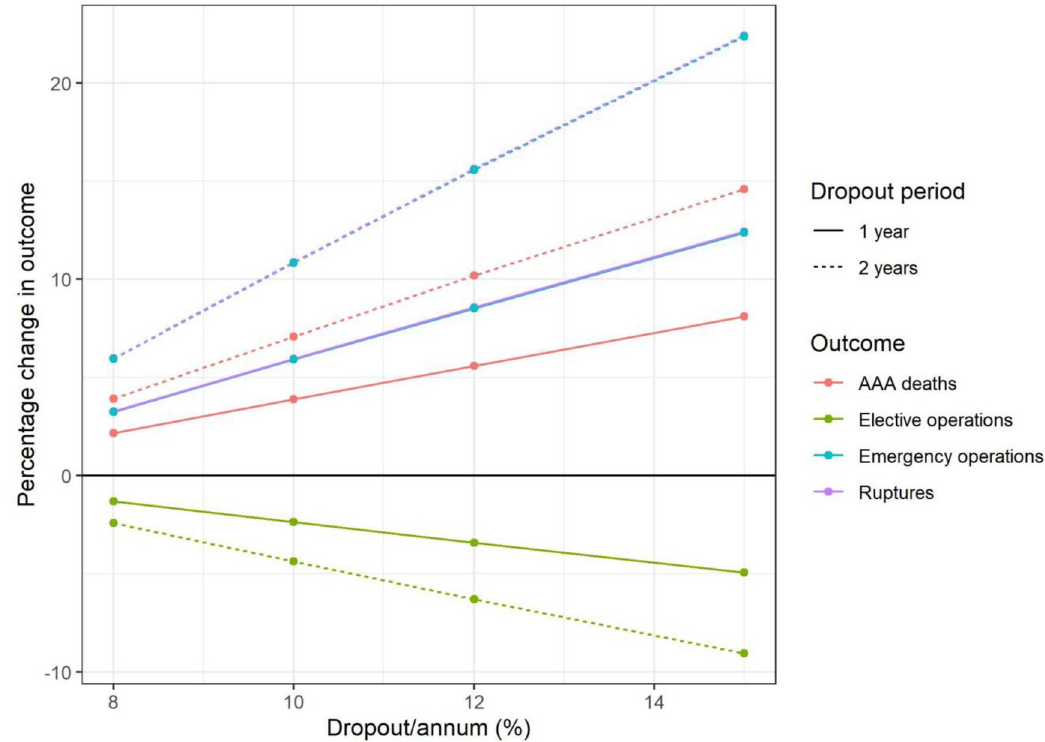
Fig 4. Surveillance cohort: Change in key outcomes over varying dropout rates, applied for (i) 1y (model I2.1) and (ii) 2y (model I2.2).